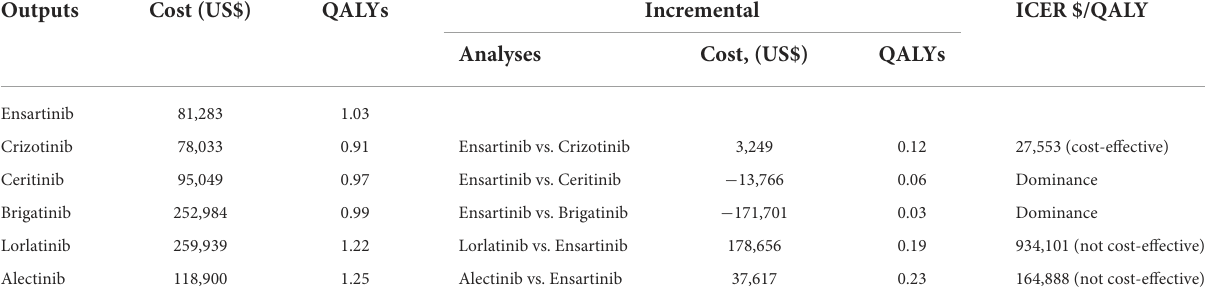
TABLE 2 Summary of simulation